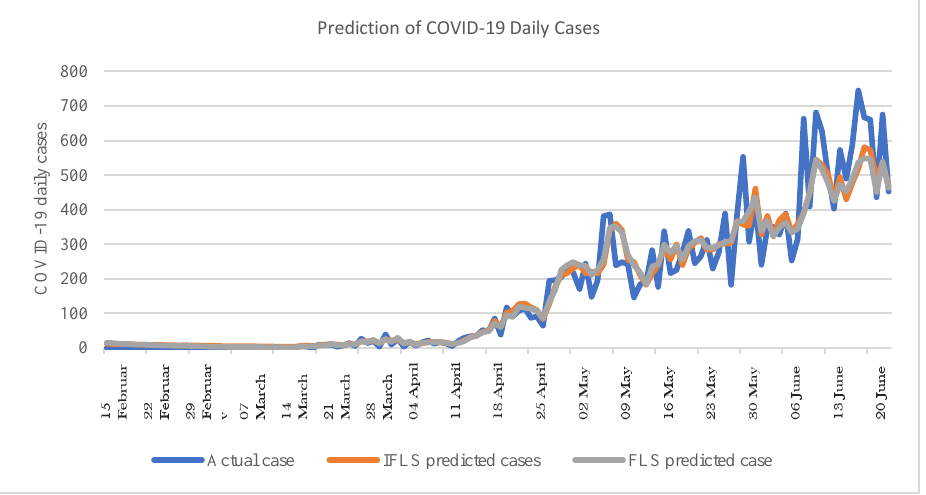
Fig. 5. Comparison of actual and predicted daily cases of COVID-19 in Nigeria using IFLS and FLS.